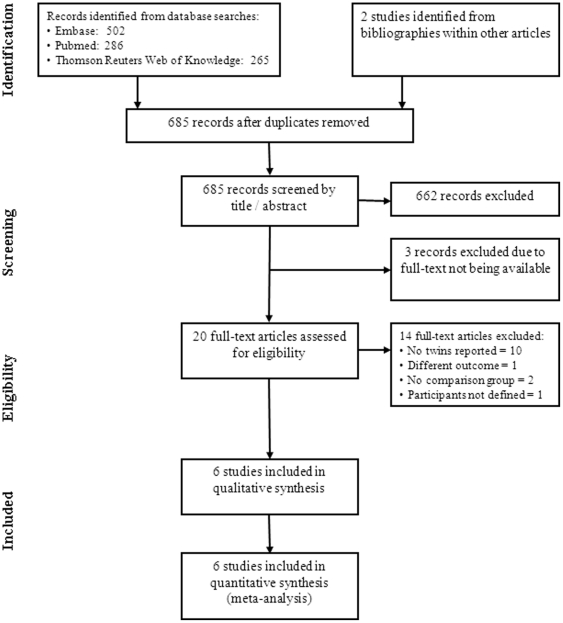
Flow chart of systematic literature search.